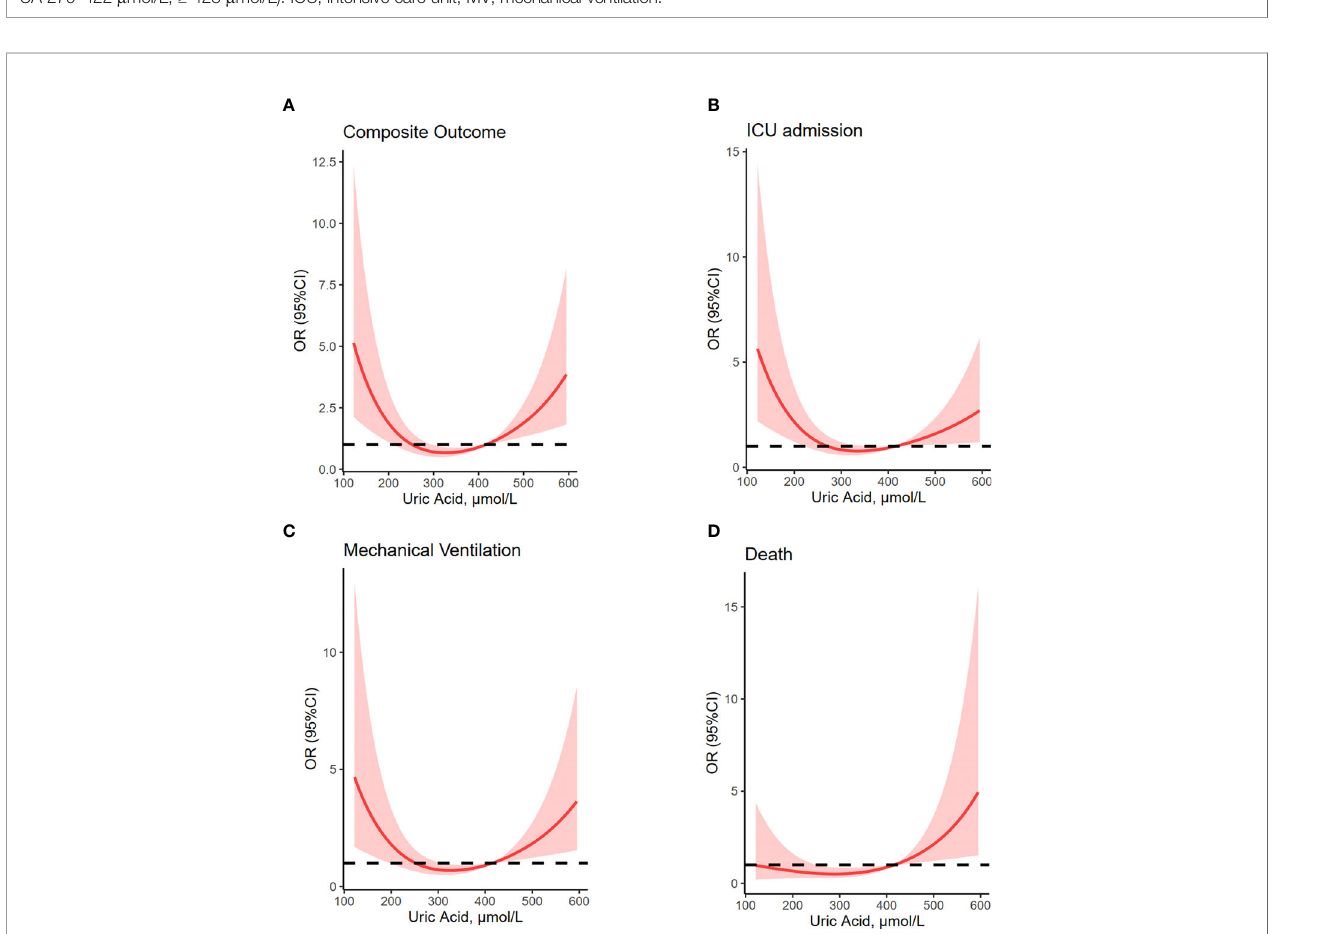
FIGURE 2 | U-shaped association between uric acid concentrations and composite outcome, ICU admission, mechanical ventilation and death. Restricted multivariable cubic spline plots show U-shaped associations between admission serum uric acid and composite outcome (A) , ICU admission (B) , mechanical ventilation (C) , and death (D) . OR were adjusted for age, sex, hypertension, diabetes, lung disease, creatine, lymphocyte and platelet counts, aspartate aminotransferase, total bilirubin, albumin, creatine, C-reactive protein and D-dimer values. Median uric acid concentrations (279 – 422 m mol/L) have been considered as reference. Shaded areas are 95% CI derived from restricted cubic spline regressions with three spaced knots at the 5th, 50th, and 95th percentiles. The dashed line indicates OR equal to 1. ICU, intensive care unit; MV, mechanical ventilation.